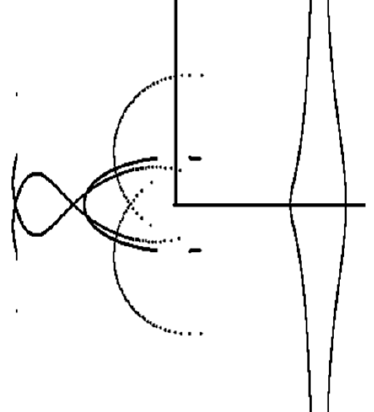
Figure 7. q = 1, KG = 60, and DK = 200.